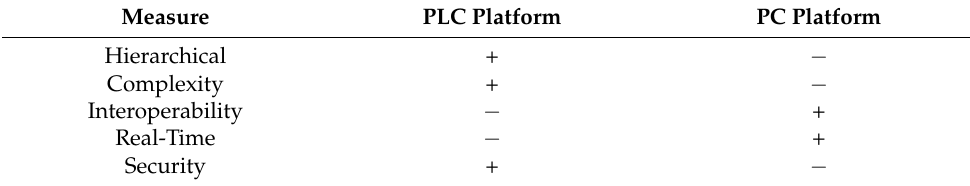
Table 4. Automatic identification